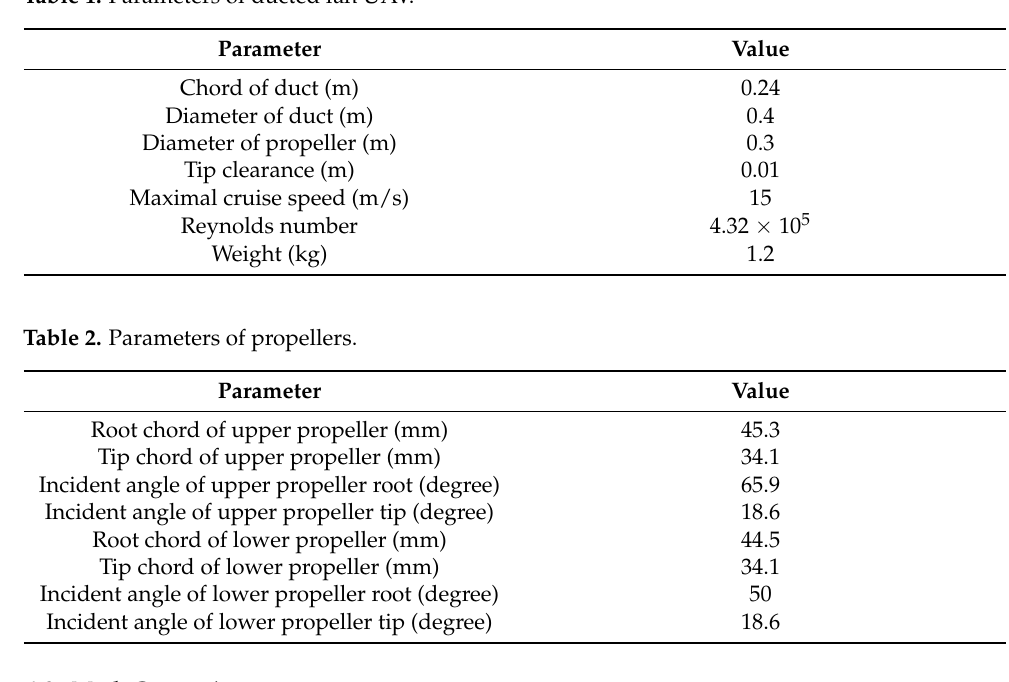
Table 1. Parameters of ducted fan UAV.